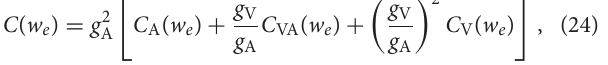
close to the present effective values g eff